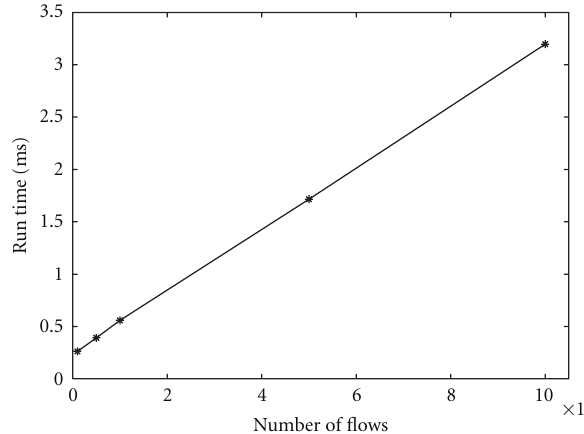
Figure 15: Model speed for increasing number of